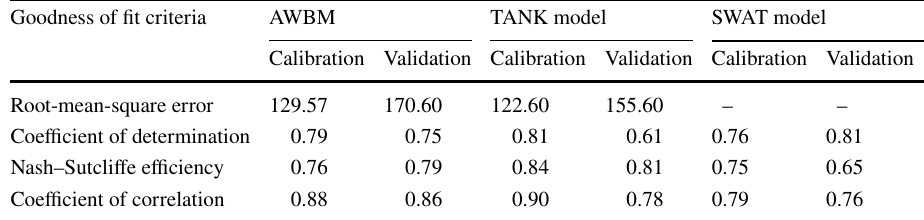
Table 7 Goodness-of-fit criterions during calibration and validation of different